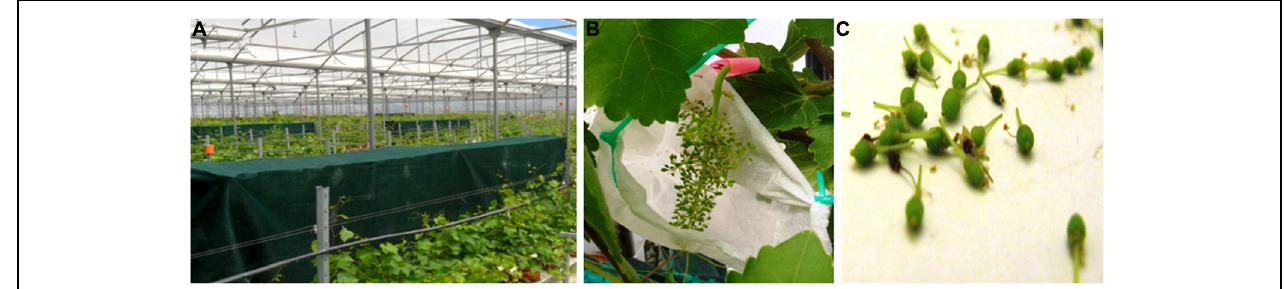
FIGURE 1 | Aspect of the experimental table grape vines (Black Magic cv) growing in greenhouse conditions (A), monitoring of flowers drop (B) and flowers detached from the base of flower pedicel (C) after abscission-inducing treatments application.